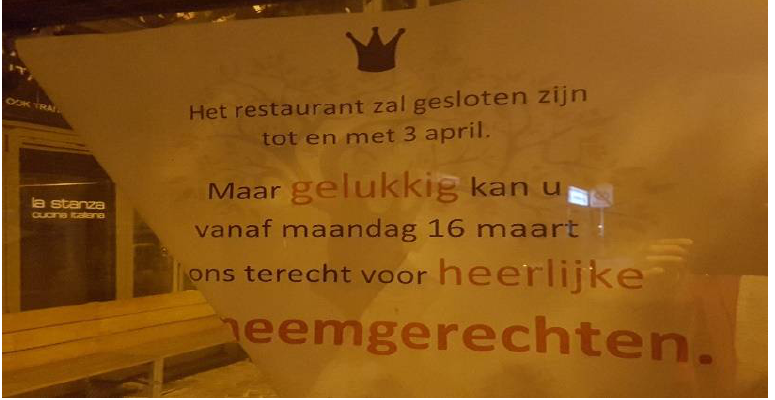
Figure 2. The restaurant will be closed until 3rd April. But luckily starting from 16 March you can drop by for delicious take-away dishes.